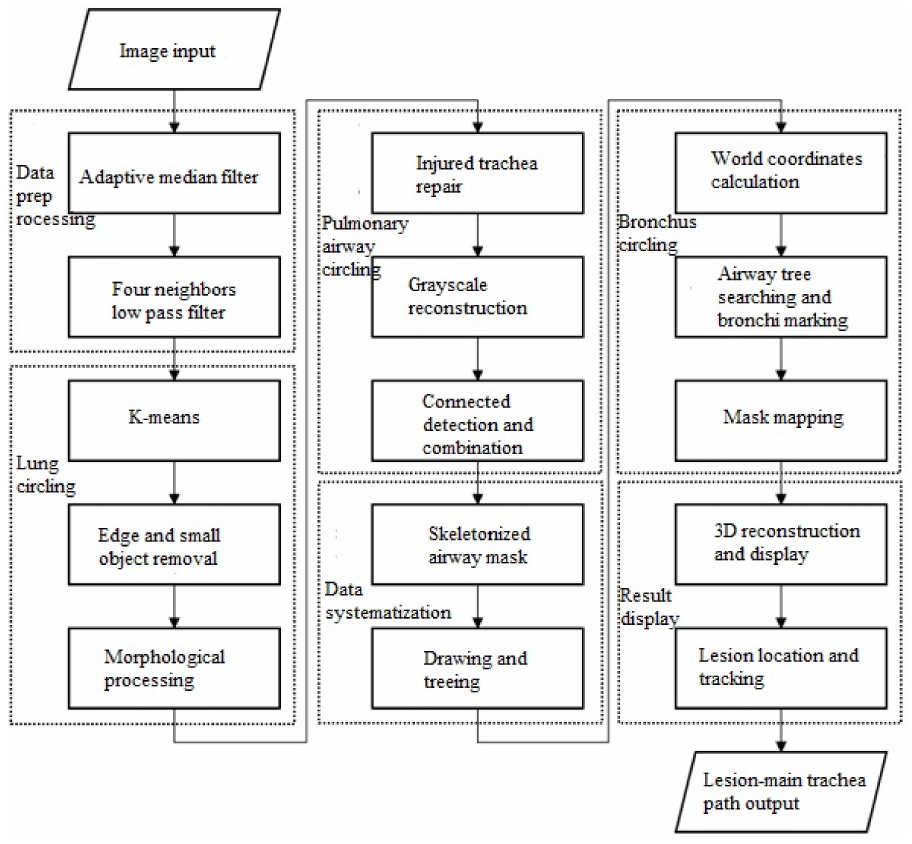
Figure 1. Image processing